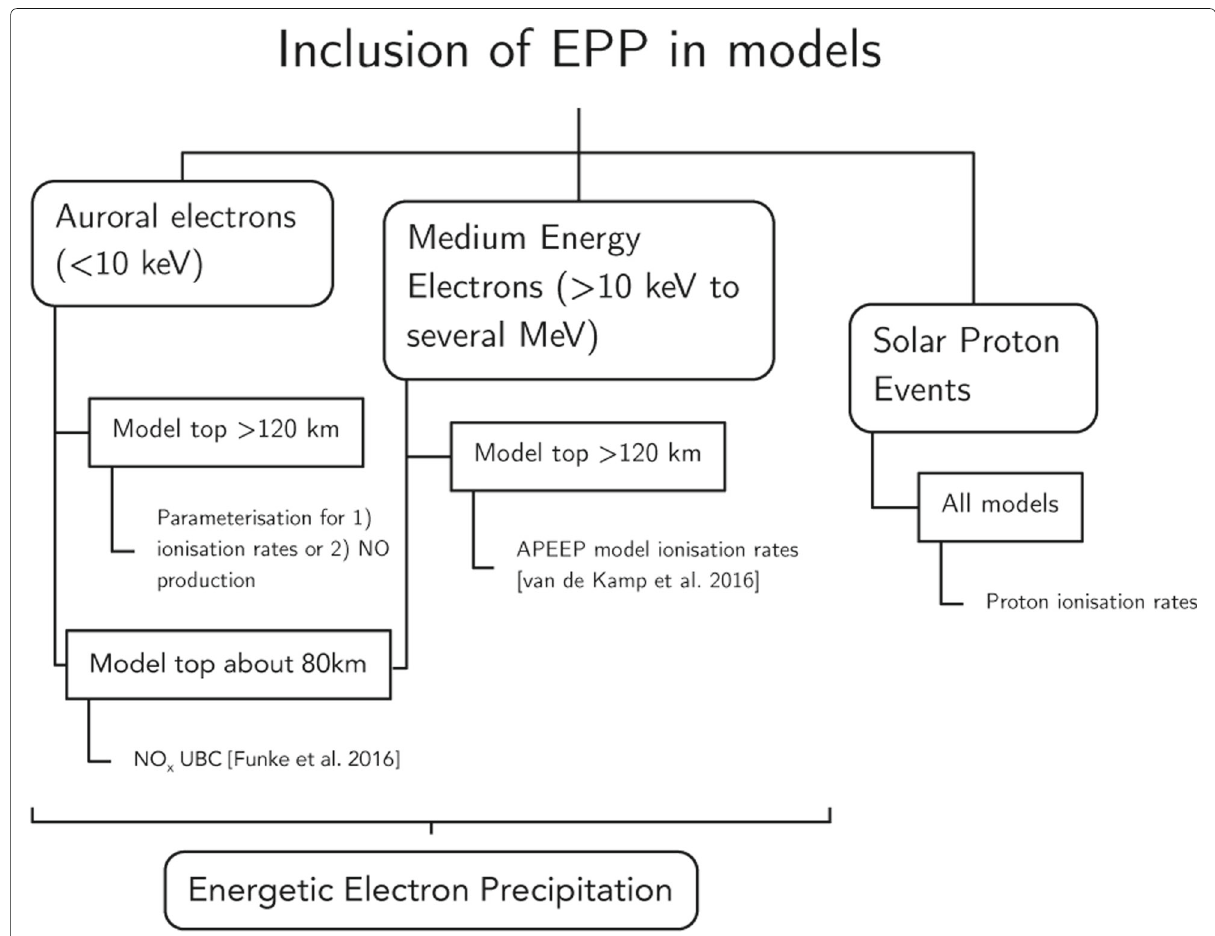
Fig. 5 CMIP6 recommendation for including EPP in model simulations. The different approaches for auroral energy electrons ( < 10 keV), medium energy electrons (MEE), and solar proton events (SPE). For details, see Matthes et al.